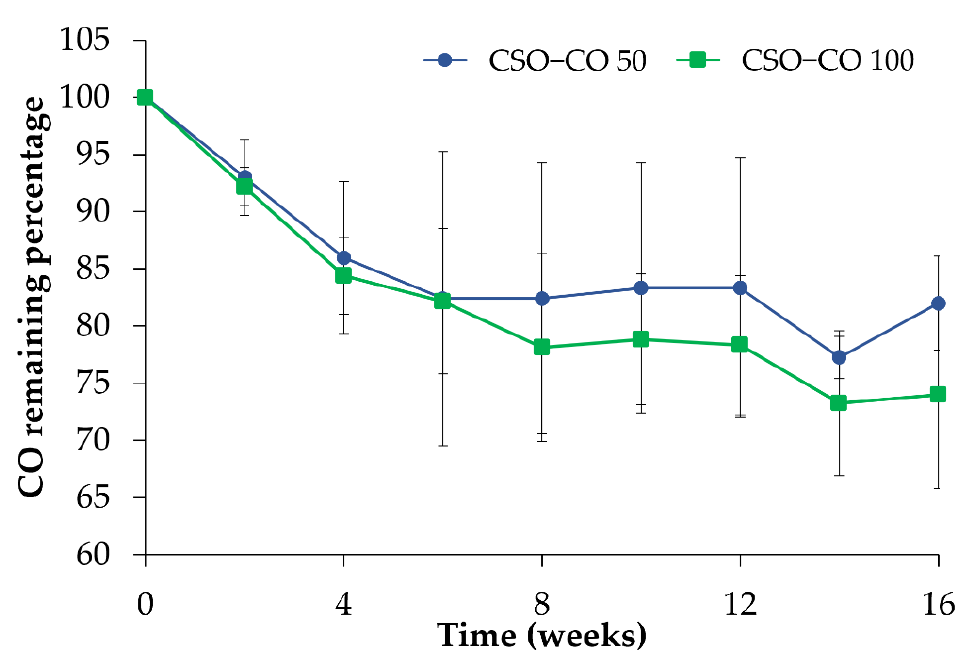
Figure 4. CO assay (%) in the CSO – CO 50 and CSO – CO 100 NE samples during storage at 4 °C (mean ± sd; n = 3).